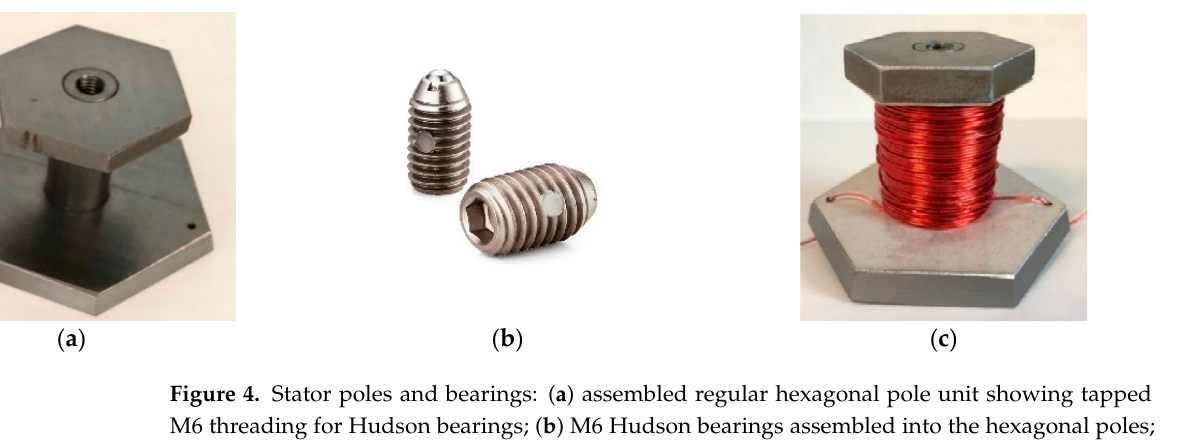
( c ) Figure 5. Stator housing: ( a ) solid model showing basic geometry; ( b ) photograph showing secured stator poles; ( c ) photograph showing external phase connections. 2.3. Rotor Design The design process for the PMSSM rotor addressed unique challenges associated with its geometry. This included optimizing the number, location, size and polarity of internally-mounted permanent magnets (PMs), while providing a smooth, thin outer shell to contact the Hudson bearings for rotor support. These design parameters were opti- mized to provide smooth and adequate torque without excessive mass and without ex- ceeding the bearings’ load capacity (29.0 N static, 9.8 N dynamic). The rotor’s outer radius was specified during the stator design process to provide a nominal air gap of 2 mm, D or = 154.4 mm. Grade N42 neodymium-iron-boron magnets (NdFeB) were selected for the rotor, based on their extremely high energy density (42 MGOe) and widespread availability in common shapes and sizes. To optimize their size, number, location and polar orientations, magnetostatic simulations were performed using FEA software (ANSYS Electronics Desk- top, Canonsburg, PA, USA). These simulations helped balance the tradeoffs between mo- tor torque and normal bearing loads. Figure 6 illustrates the relationship between magnet size and normal bearing load for maximum stator pole excitation (300 A-t).